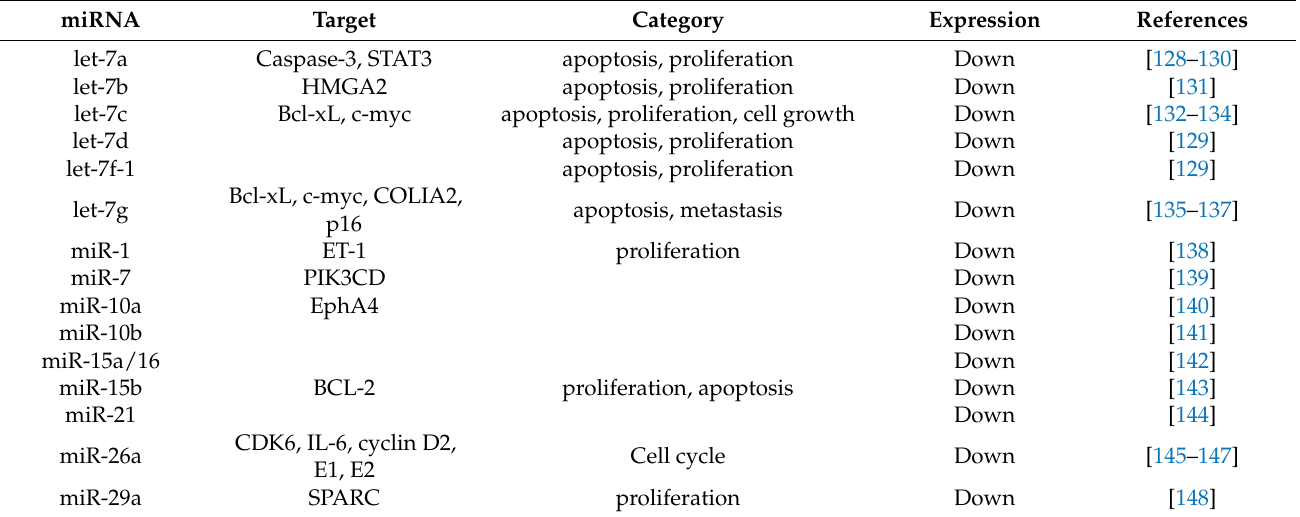
Table 1. Downregulated and upregulated miRNAs in